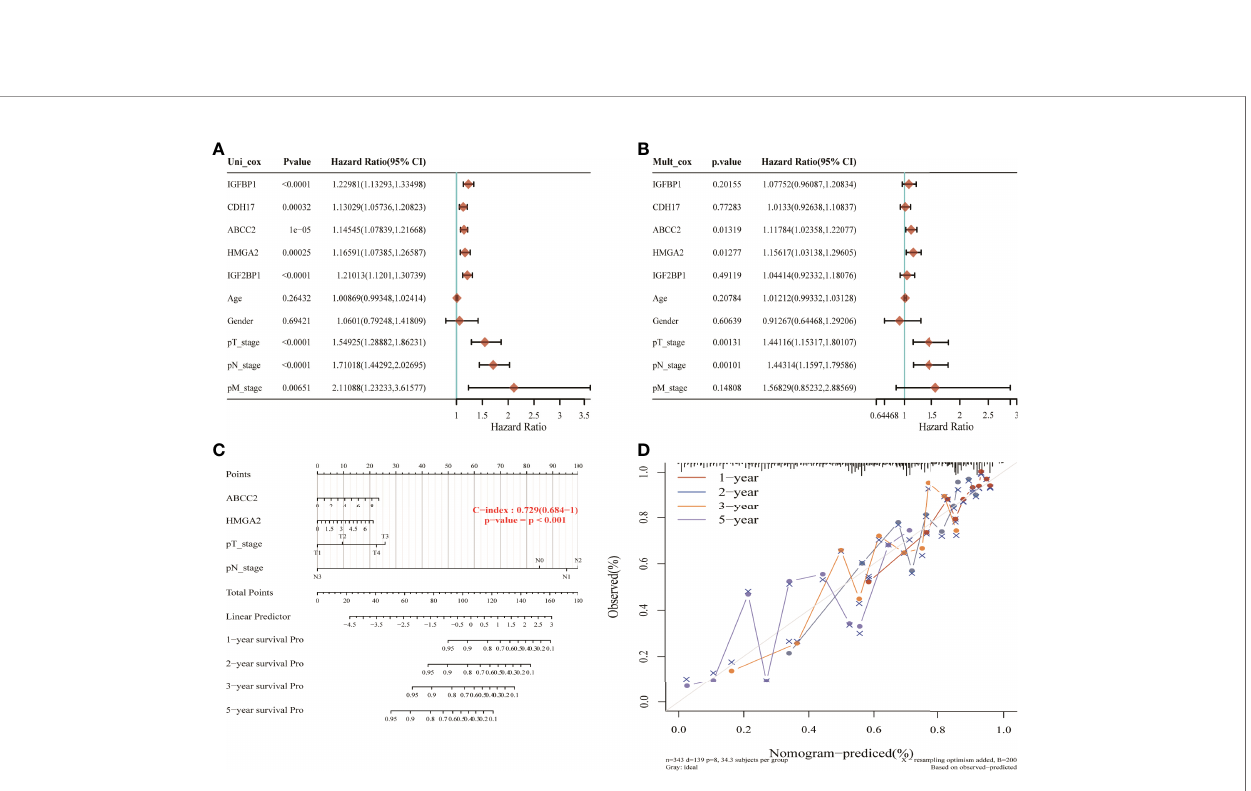
FIGURE 7 | Differential expression analysis of risk scores involved in immune. (A – C) The aDCs was signi fi cantly higher in the low-risk group in the three datasets. (D – F) The type II interferon response was signi fi cantly higher in the low-risk group than in the high-risk group in the three datasets.